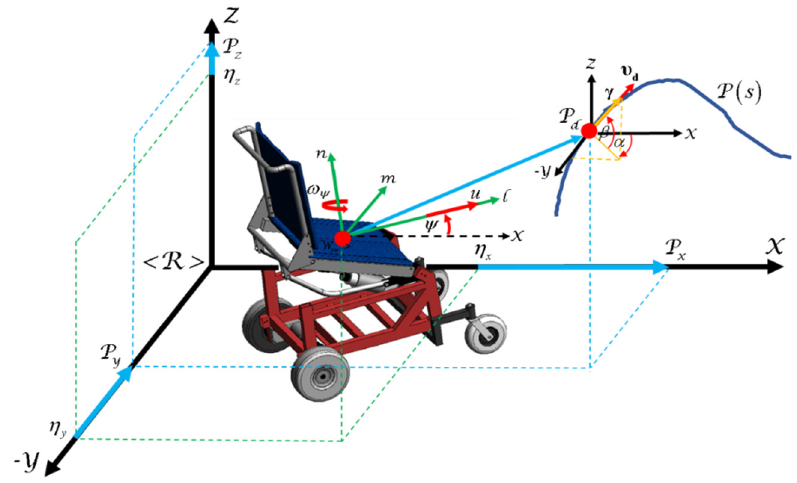
Sensors 2021 , 21 , x FOR PEER REVIEW Figure 13. Path-following problem for a robotic standing wheelchair. Figure 13. Path-following problem for a robotic standing wheelchair.